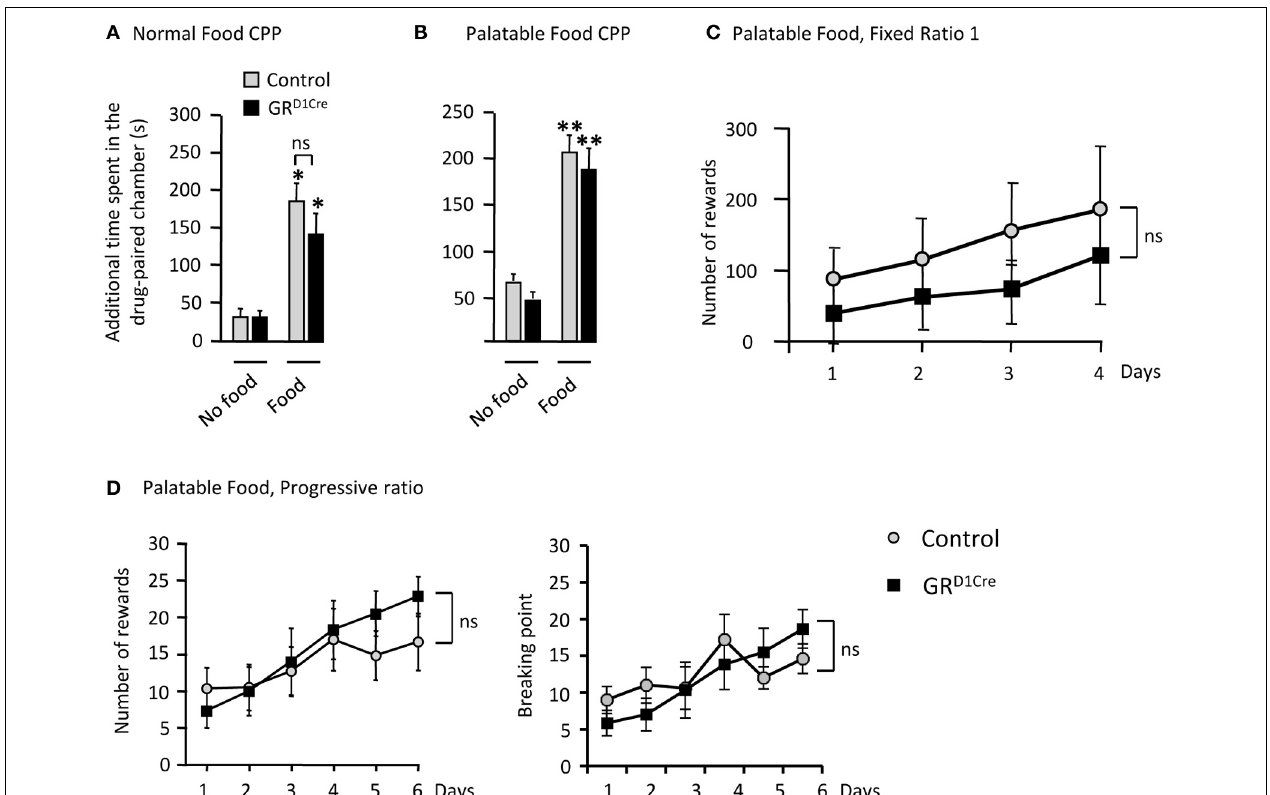
FIGURE 6 | Unaltered responses to food reward in GR D1Cre mice. CPP scores represent the time difference between post-conditioning and pre-conditioning phases that mice spent in the reward-paired chamber. (A) Control and GR D1Cre mice show similar levels of CPP when normal chow pellet were use as a conditioning stimulus. Effect of Food F ( 1 , 33 ) = 4 . 4, P < 0 . 05, but no effect of genotype F ( 1 , 33 ) = 0 . 9, P > 0 . 05. (B) Similar responses were also obtained when control and GR D1Cre mice were paired with palatable food, which significantly increased the time spent in the paired